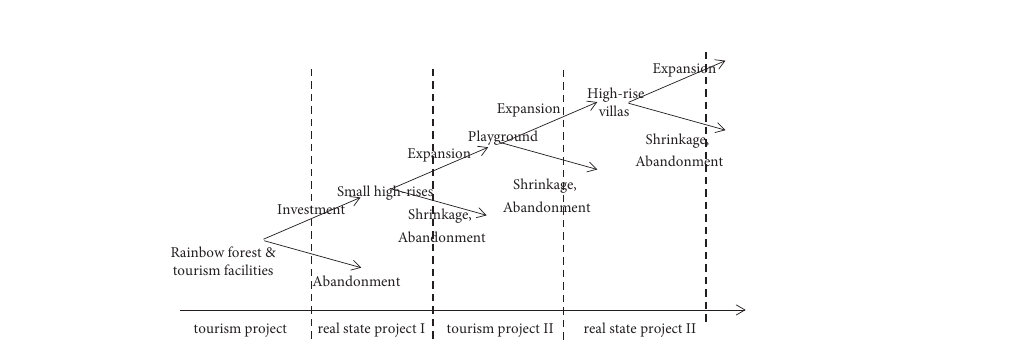
Figure 2: Improved development phases of tourism real estate